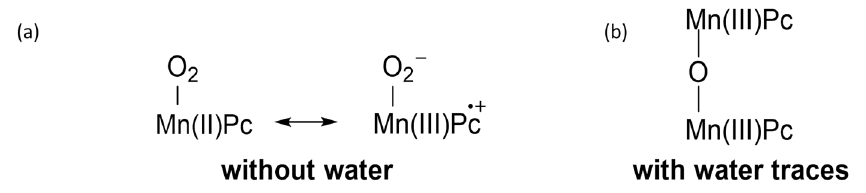
Figure 3. Electronic arrangements of Mn(II)Pc after reaction with dioxygen: ( a ) in the absence of water and ( b ) in the presence of water traces.